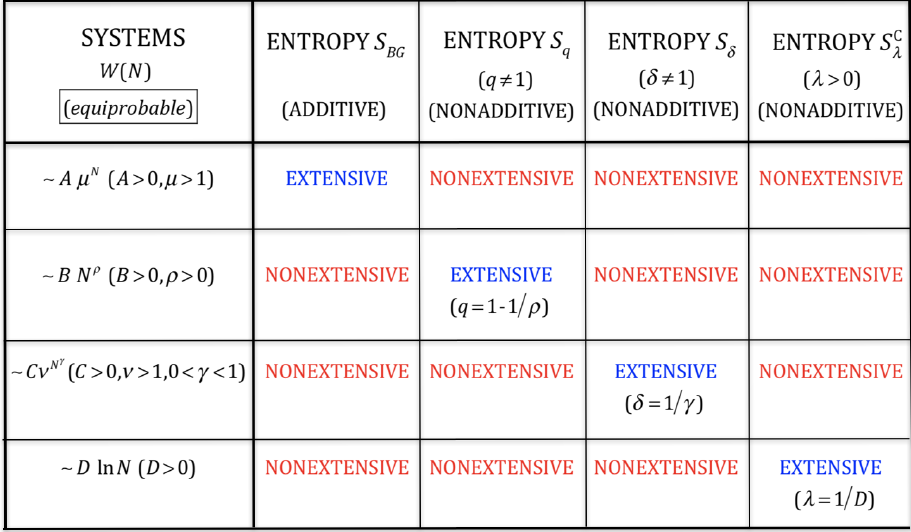
Figure 1. Typical behaviors of W ( N ) (number of nonzero-probability states of a system with N random variables) in the N → ∞ limit and entropic functionals which, under the assumption of equal probabilities for all states with nonzero probability, yield extensive entropies for specific values of the corresponding (nonadditive) entropic indices. In what concerns the exponential class W ( N ) ∼ A µ N , S BG is not the unique entropy that yields entropic extensivity; the (additive) Renyi entropic functional S R q also is extensive for all values of q . Analogously, in what concerns the stretched-exponential class W ( N ) ∼ C ν N γ , the (nonadditive) entropic functional S δ is not unique. All the entropic families illustrated in this table contain S BG as a particular case, except S C , which is appropriate for the λ logarithmic class W ( N ) ∼ D ln N . In the limit N → ∞ , the inequalities µ N (cid:29) ν N γ (cid:29) N ρ (cid:29) ln N (cid:29) 1 are satisfied, hence lim N → ∞ ν N γ / µ N = lim N → ∞ N ρ / µ N = lim N → ∞ ln N / µ N = 0. This exhibits that, in all these nonadditive cases, the occupancy of the full phase space corresponds essentially to zero Lebesgue measure, similarly to a whole class of (multi) fractals. If the equal probabilities hypothesis is not satisfied, specific analysis becomes necessary and the results might be